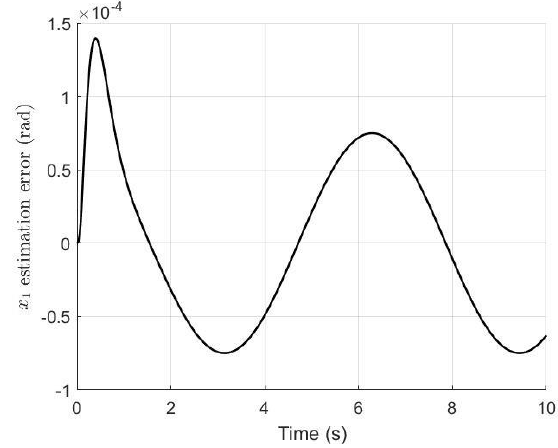
Figure 10. Experiment 3. Plot of the estimation error x 1 ( t ) − v ( t ) / a 43 .